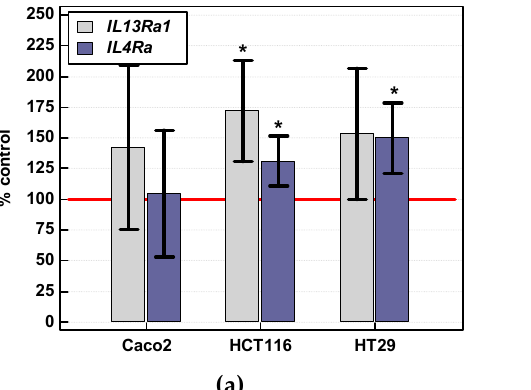
(b) Figure 10. Relative expression of IL4Ra and IL13Ra1 in colon cancer cells lines: ( a ) IL4Ra ; ( b ) IL13Ra1 . Data analyzed as logs using one-way ANOVA and presented as geometric means ± SE ( n = 2–6) of normalized relative quantities [NRQ]. Expression levels were normalized against GAPDH expression and presented in relation to geometric mean of gene expression across all samples (represented by horizontal red line). Statistically significant differences between groups are marked with symbols of the same type (*, #, etc.). Subsequently, potential effects of nutritional stress (serum withdrawal) and chemically induced hypoxia on IL4Ra and IL13Ra1 expression in Caco-2, HCT 116, and HT-29 cells was evaluated. IL4Ra expression was slightly upregulated by serum starvation in HCT 116 and HT-29, but not